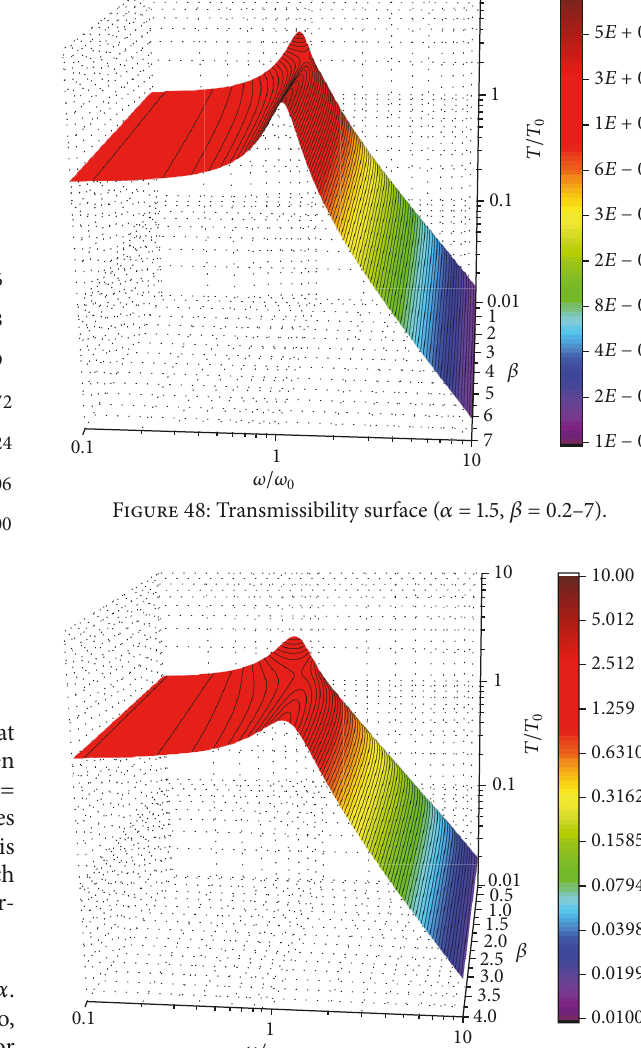
Figure 45: Comparison of resonance peaks.